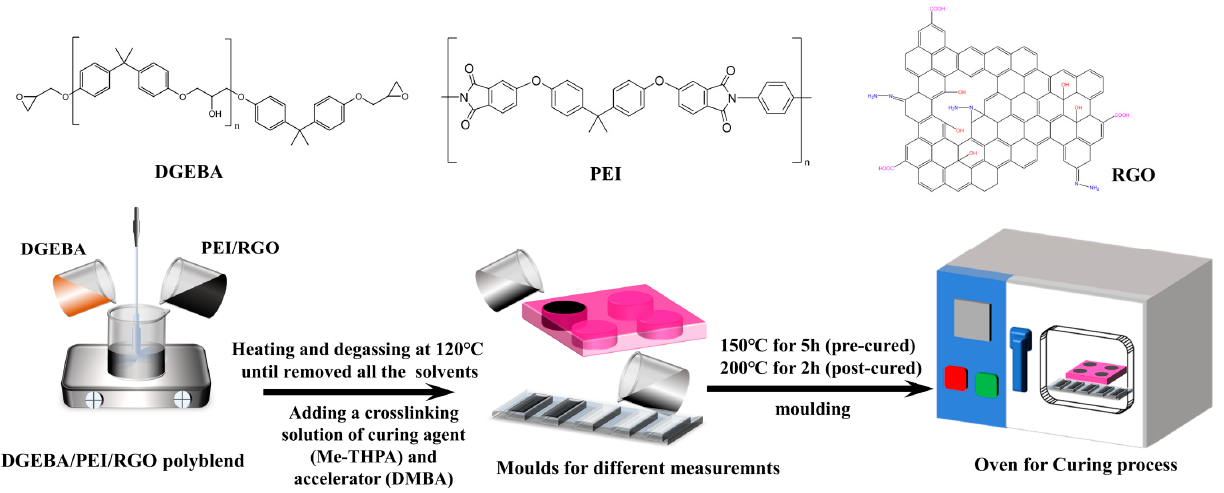
Figure 1. Schematic of the fabrication of DGEBA/PEI/RGO nanocomposites.